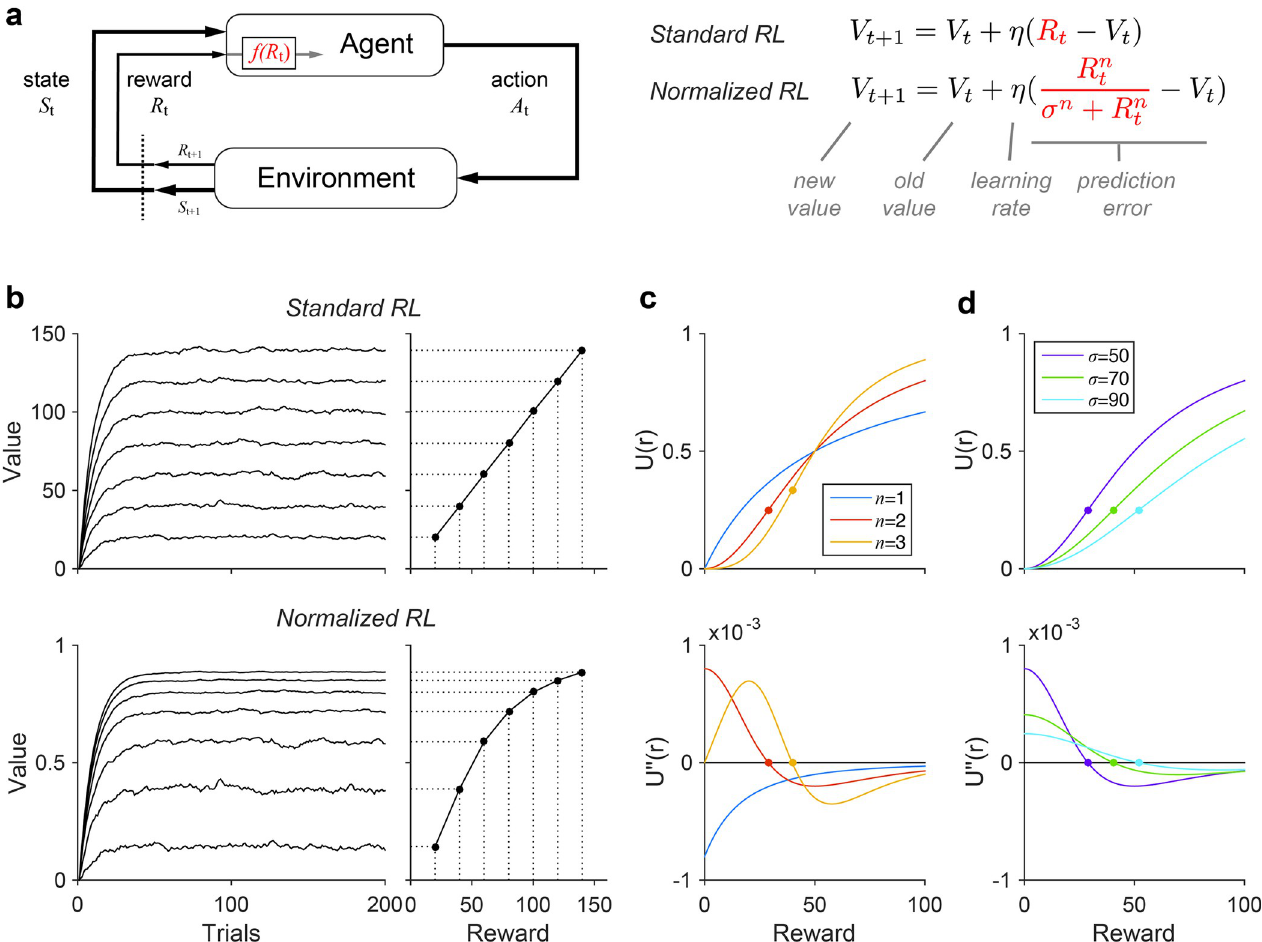
Fig 1. Normalized reinforcement learning model. (a) Comparison of standard reinforcement learning (RL) and normalized reinforcement learning (NRL) models. RL and NRL differ in how external rewards are transformed by the reward coding function f ( R t ) prior to learning internal value estimates. Standard RL uses a linear reward function, while NRL uses a divisively normalized representation. (b) Learned value functions under RL and NRL. Left, dynamic value estimates during learning. Right, steady state value estimates. Simulations were performed for each of seven rewards, with additive zero-mean Gaussian noise (learning rate η = 0.1). In contrast to RL, NRL algorithms learn values that are a nonlinear function of external rewards (example NRL simulation parameters: σ = 50, n = 2). (c) Convexity and concavity in NRL value functions. Top, NRL value functions with different exponents (fixed σ = 50 A.U.). Bottom, second derivative of value functions. Dots show inflection points between convex and concave value regimes. (d) Parametric control of NRL value curvature. NRL value function (top) and second derivative (bottom) for different σ values (fixed n =